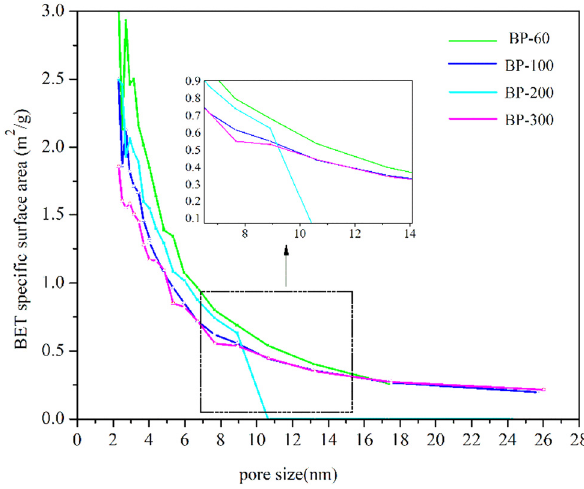
Figure 3: Pore size and S BET of BP.